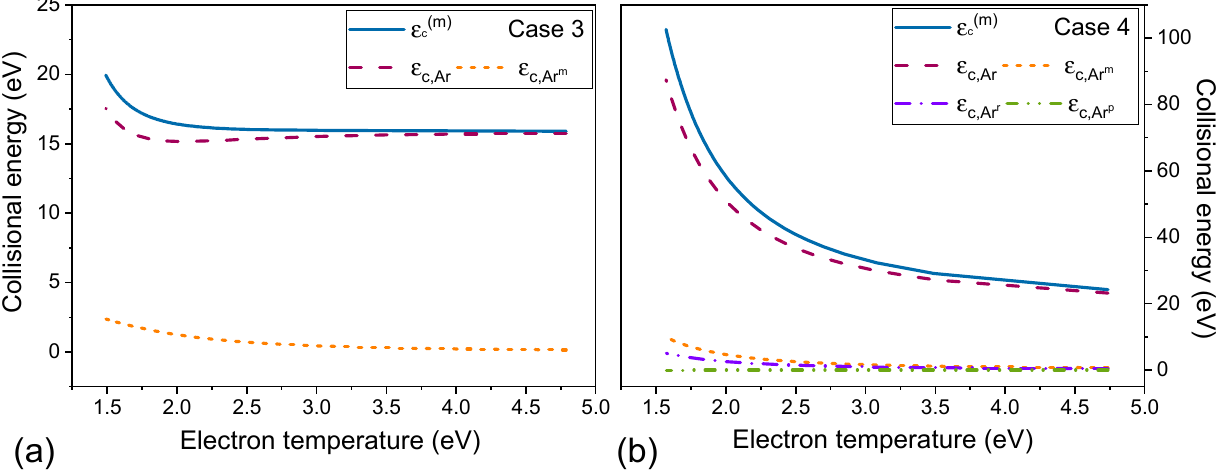
Figure 6. Collisional energy of each species that contributes to ionization: Ar and Ar m for case 3 ( a ) and Ar, Ar m , Ar r, and Ar p for case 4 ( b ) as a function of electron temperature for absorbed power of 300 W. In both graphs ε (cid:2913)((cid:2923)) is the multistep collisional energy.